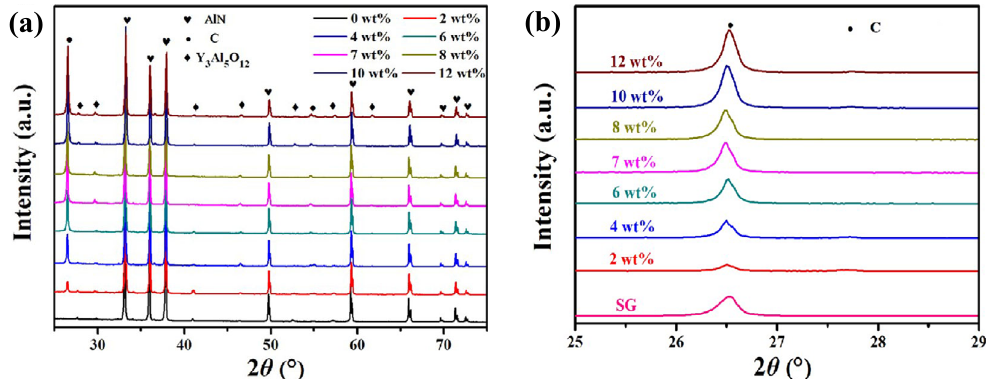
Fig. 3 (a) XRD patterns of SG/AlN composites with different SG contents and (b) XRD patterns of SG raw powders and SG/AlN composites with different SG contents at